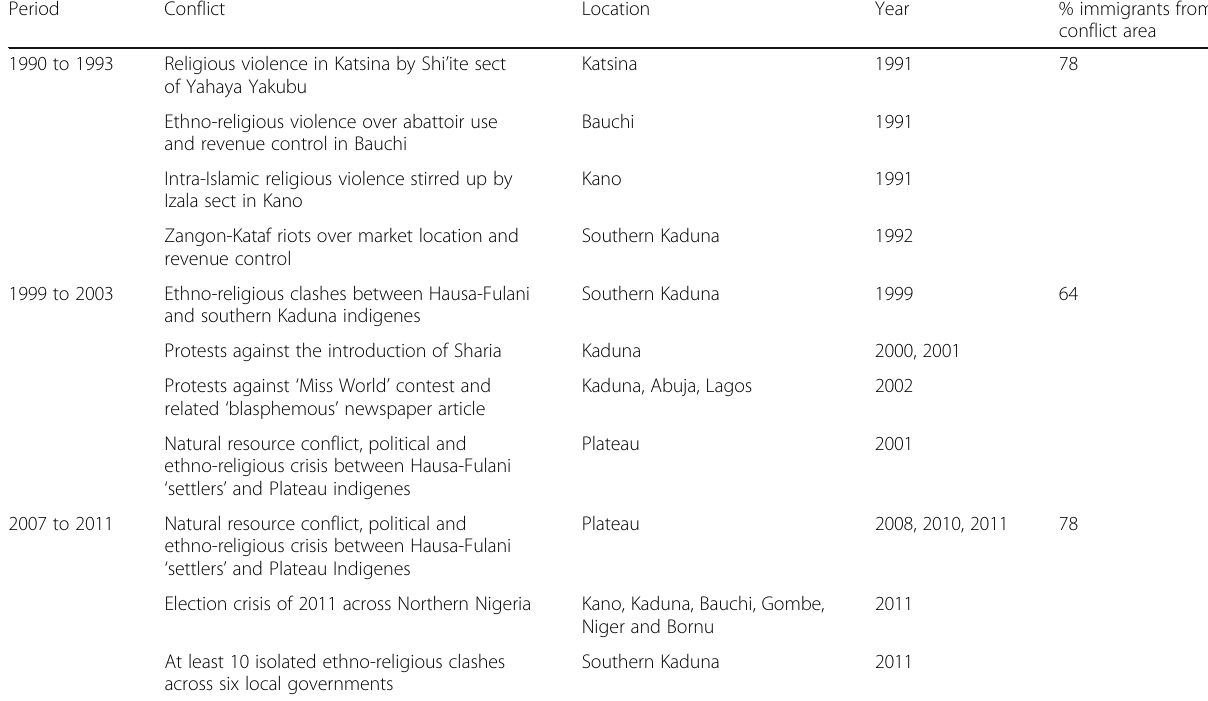
Table 2 Proportion of immigrants from conflict areas during peak periods of immigration (IRBC 1993; Osaghae and Suberu 2005; Falola 1998; HRW 2003, 2001; IFRC 2011; Higazi 2013)